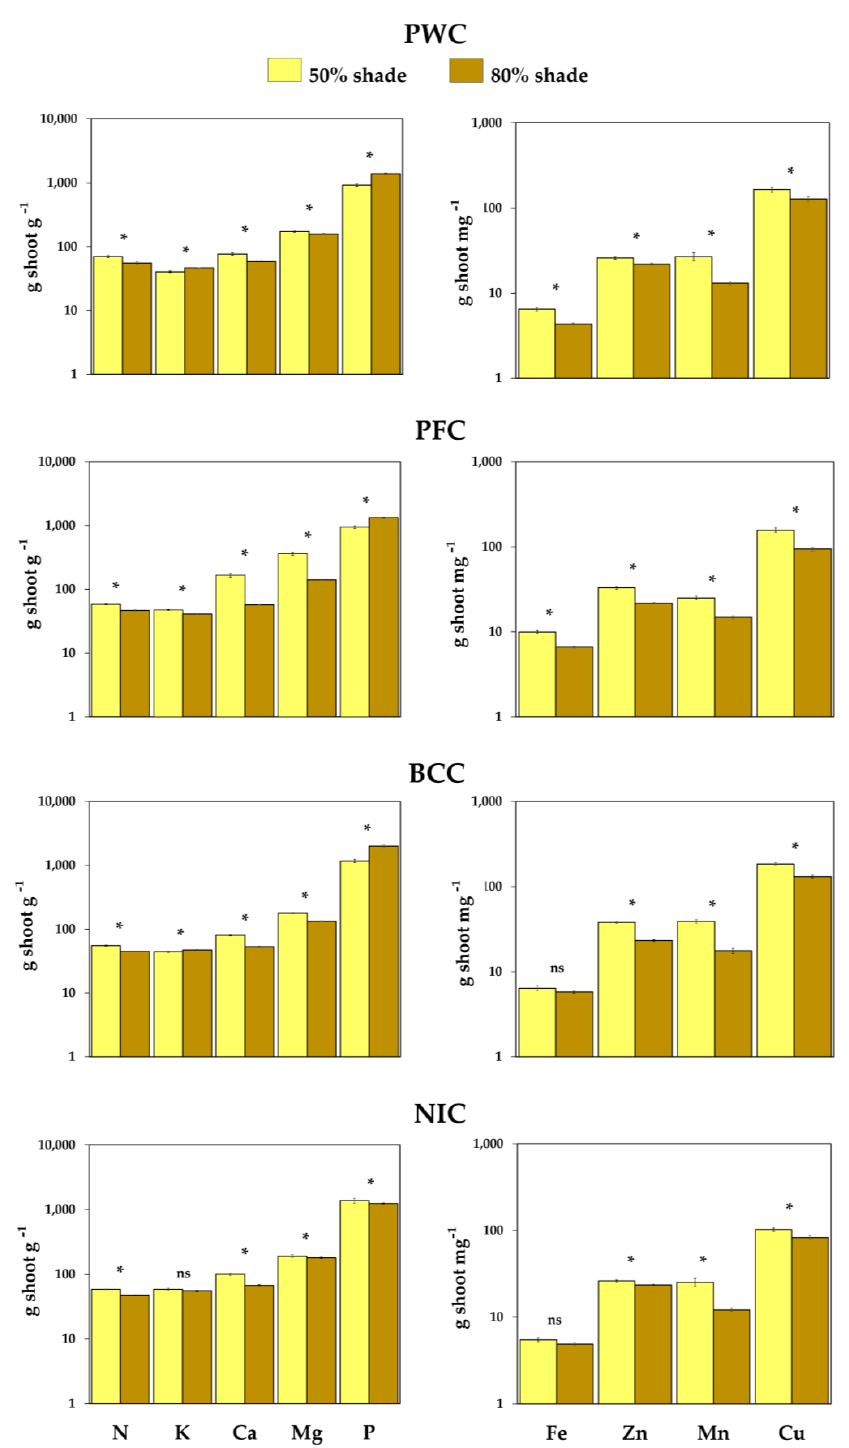
Figure 3. Effect of shade on nutrient uptake efficiency (NUE, macronutrients in g shoot g − 1 or micronutrients in g shoot mg − 1 ± SE) of cacao genotypes subjected to two levels of shade (50%, 80%). PWC: wild cacao (from river basins of Peruvian Amazon) [ n = 14]; PFC: Peruvian farmers’ cacao [ n = 15]; BCC: Brazilian cacao [ n = 14]; NIC: national and international cacao collections [ n = 15]. All paired bar graphs that have an * above have significant differences and those with “ns” above do not have significant differences between shade levels (Scott and Knott test, p ≤